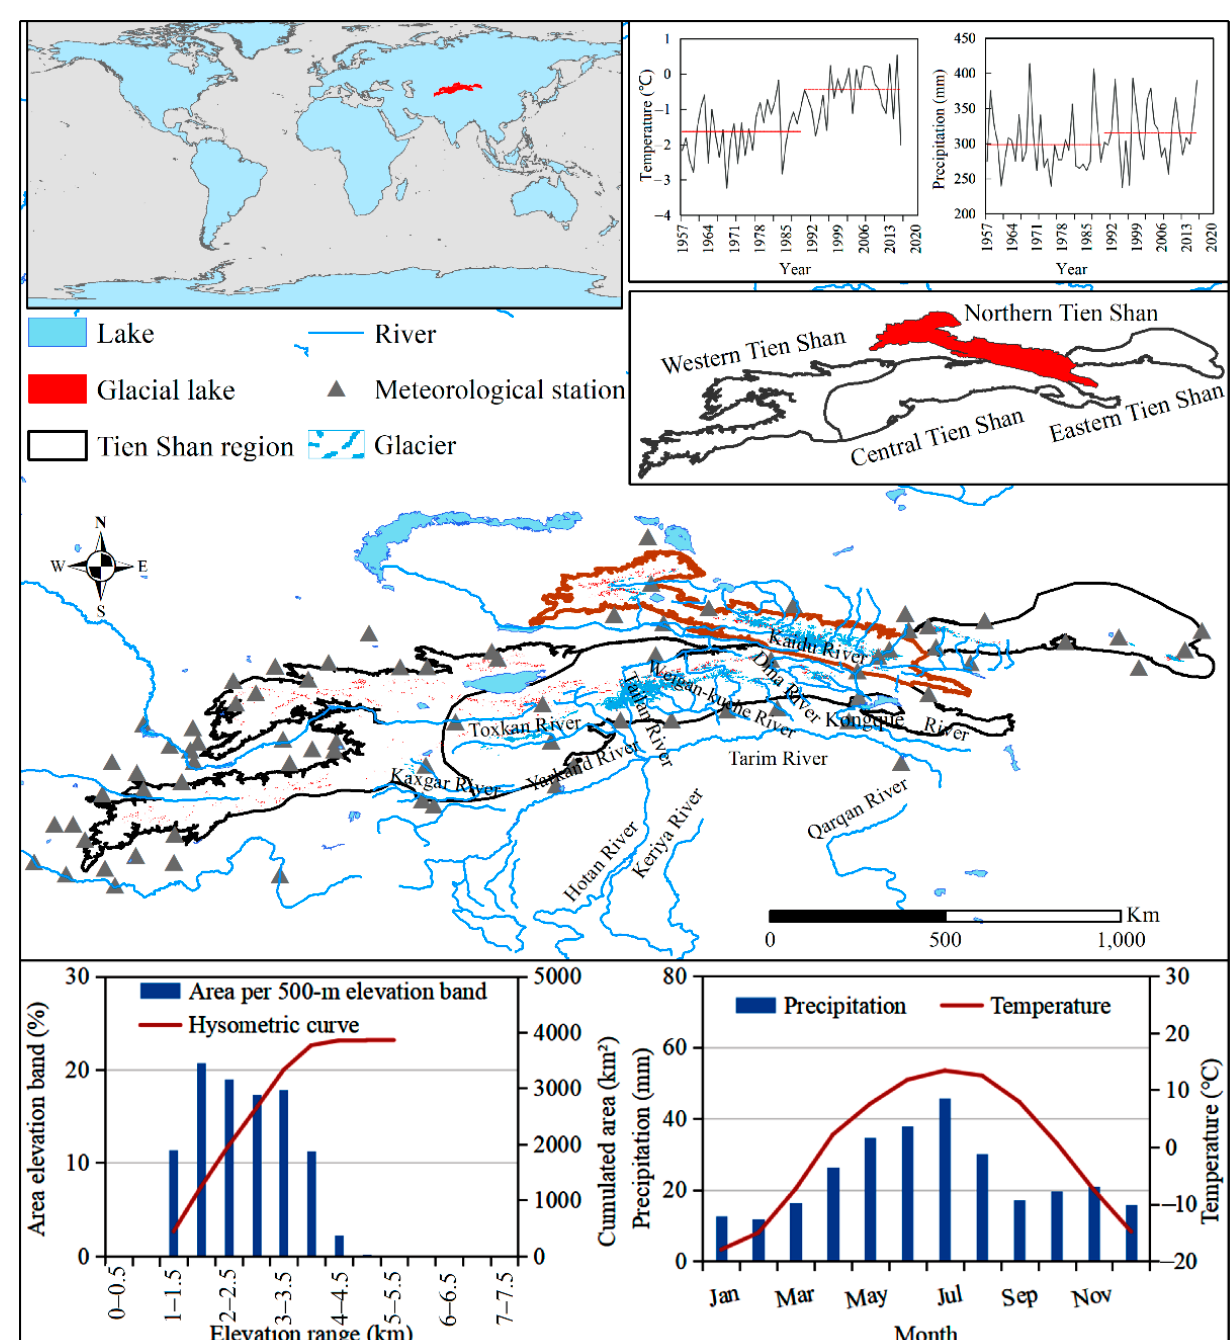
Figure 1. Study region of the northern Tien Shan, Central Asia.